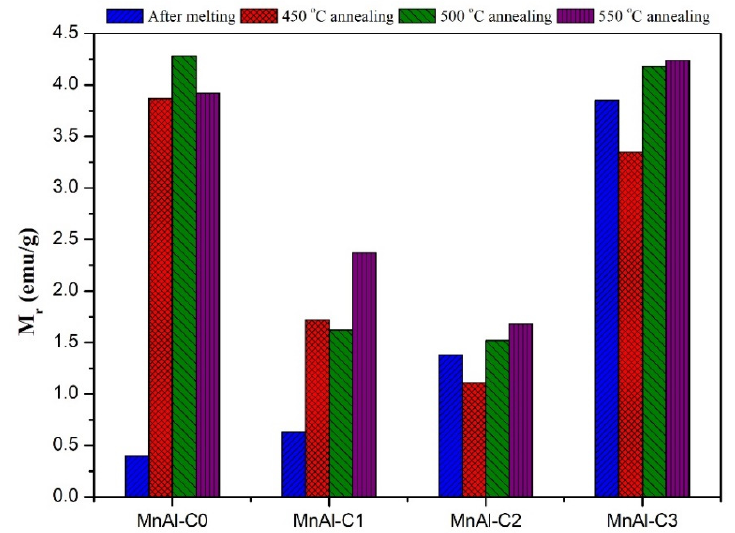
Figure 5. Remanent magnetization (M r ) of (Mn 55 Al 45 ) 100-x C x powders before and after annealing for 20 min at 450, 500, and 550 °C under argon atmosphere.